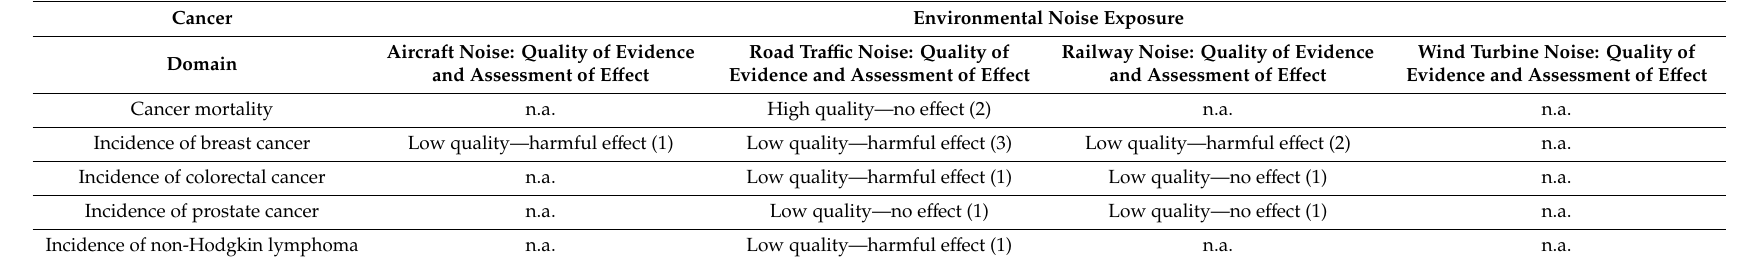
Table 8. Summary of the strength of the evidence for